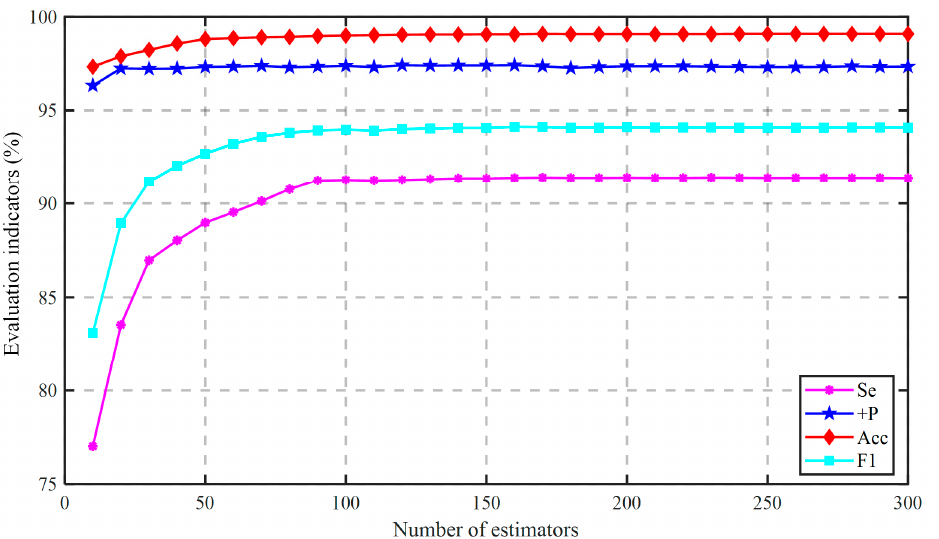
Figure A1. The coarse-grained tuning of the “n_estimators”.